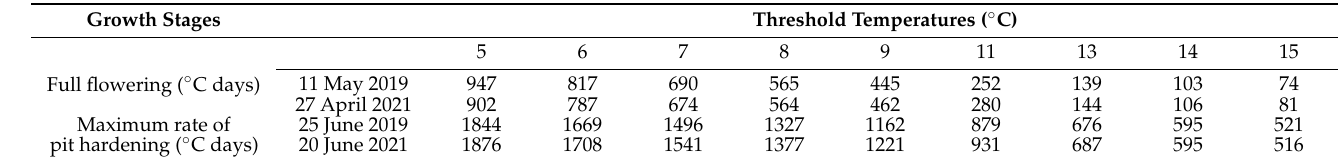
Table 3. Growing degree days (GDDs, ◦ C days) at different threshold temperatures for two main olive growth stages during two “on” years.